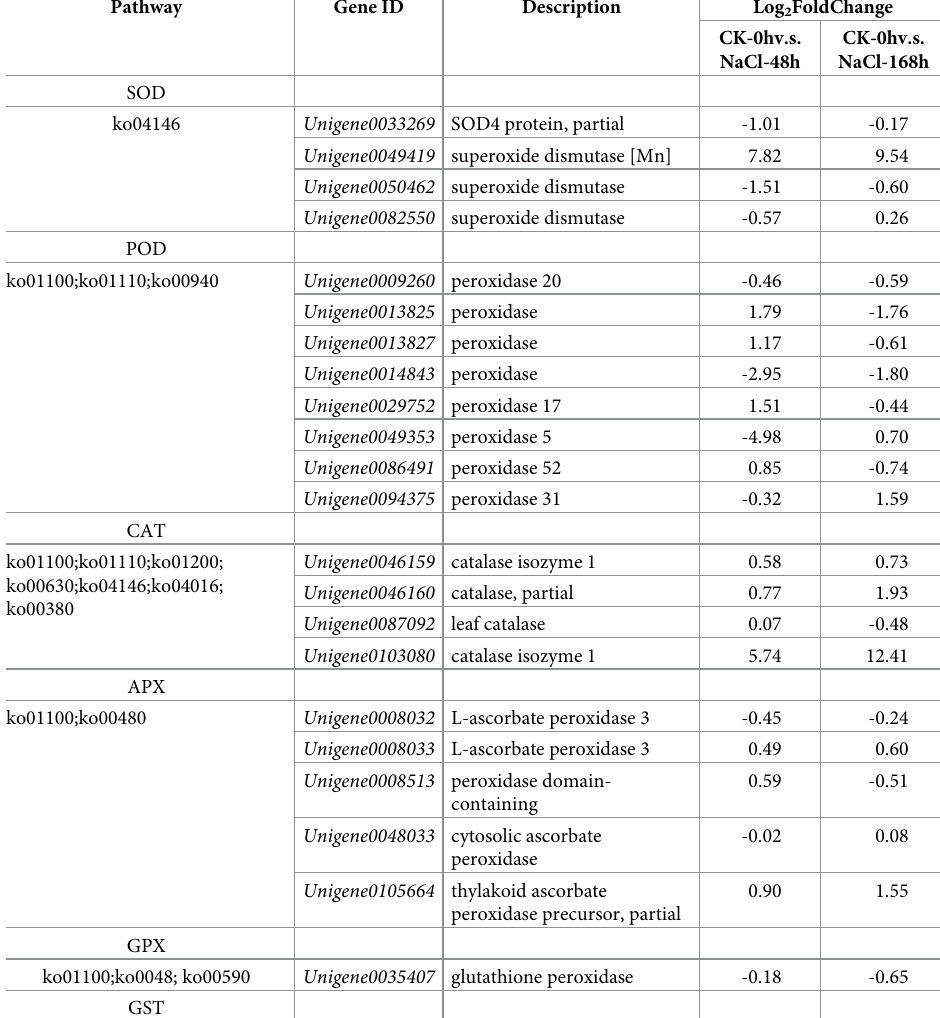
Table 5. Antioxidant DEGs annotated to the KEGG